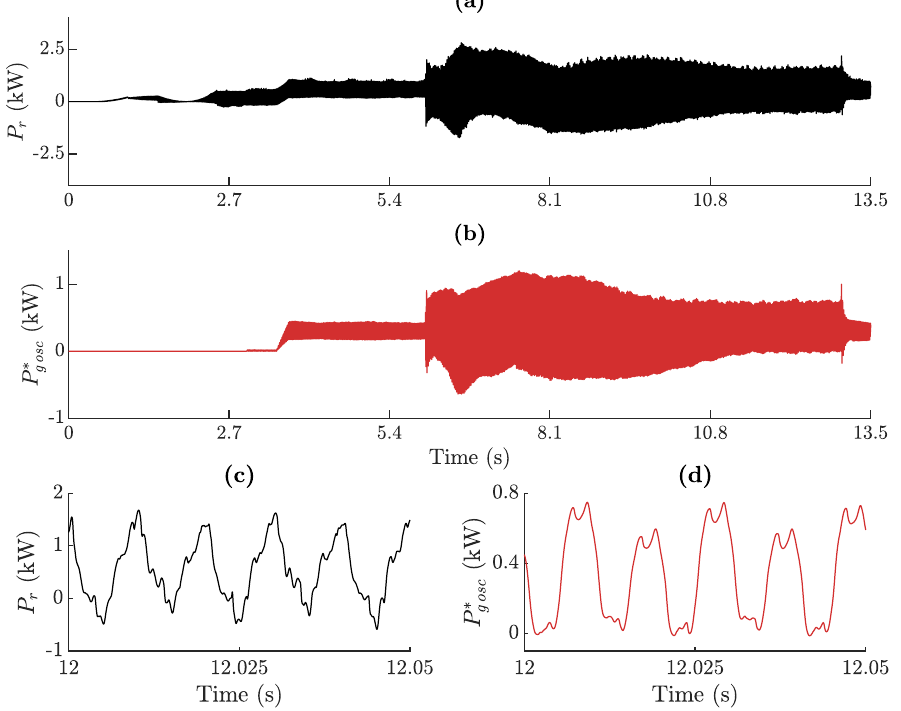
Figure 8. Profiles for P r and P ∗ gosc throughout the test: ( a ) P r ; ( b ) P ∗ gosc ; ( c ) detail of P r at the steady